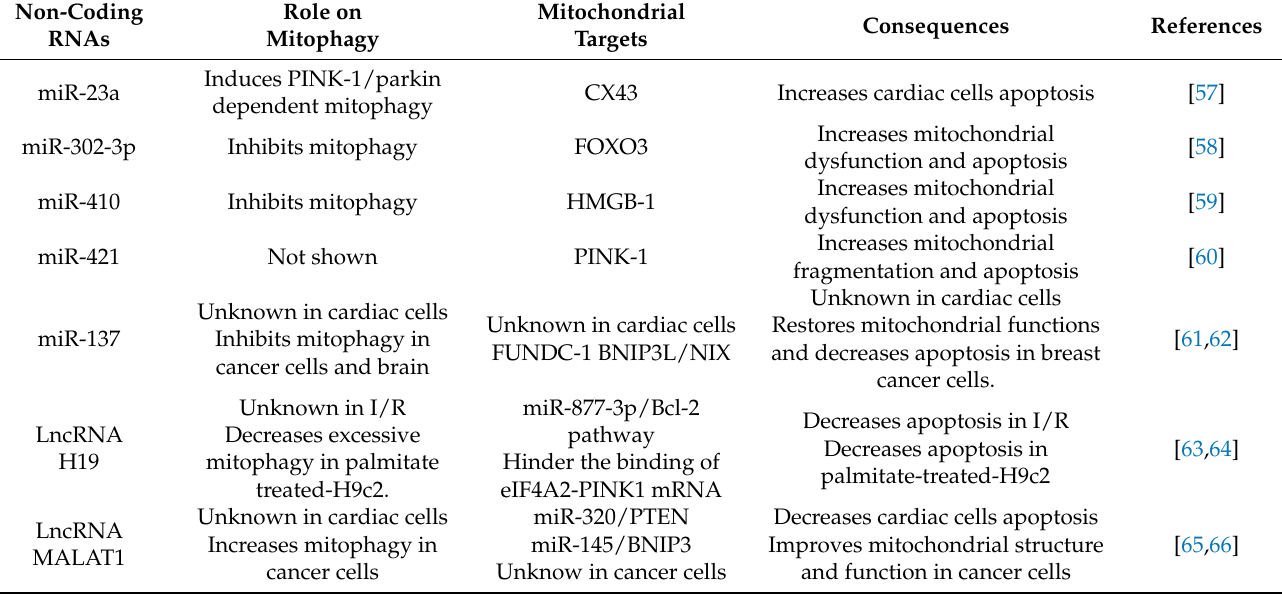
Table 1. Role of non-coding RNA regulated during and post-MI on mitophagy regulation.